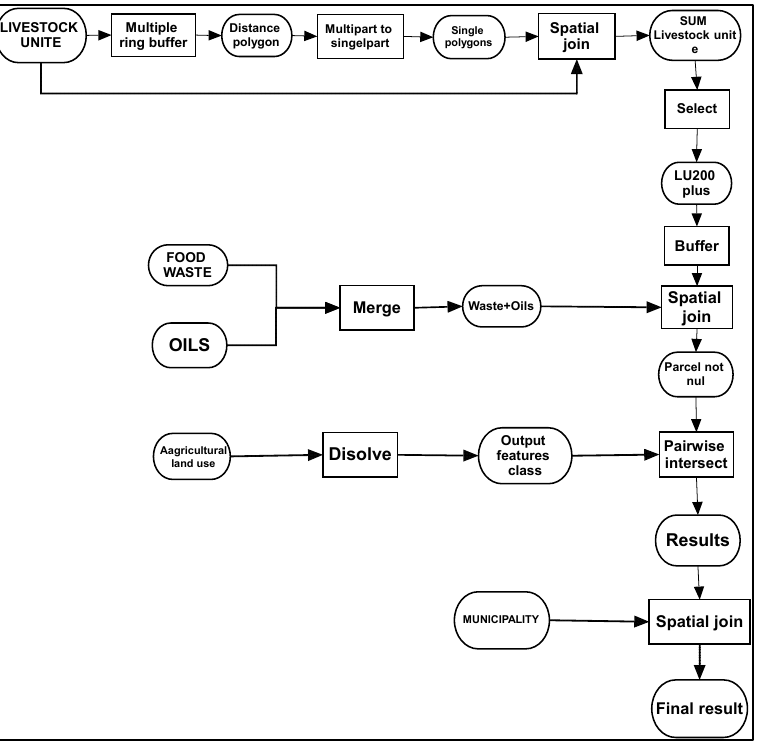
Figure 4. Flowchart and sets of input data in the model.